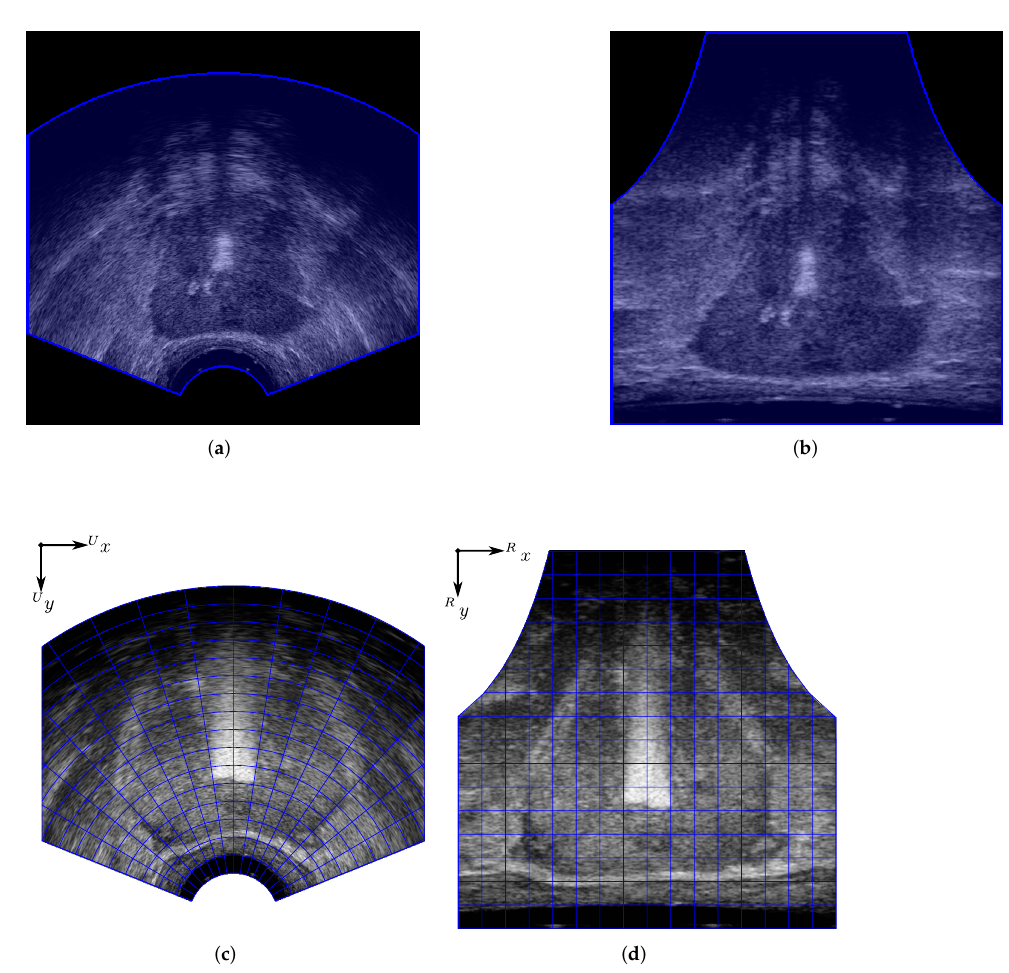
Figure A1. Ultrasound image preprocessing region of interest and warping. ( a ) TRUS image with region of interest indicated by the shaded blue area; ( b ) Warped TRUS image with region of interest indicated by the shaded blue area; ( c ) TRUS image U x − U y axes; ( d ) Warped TRUS region of interest image R x − R y